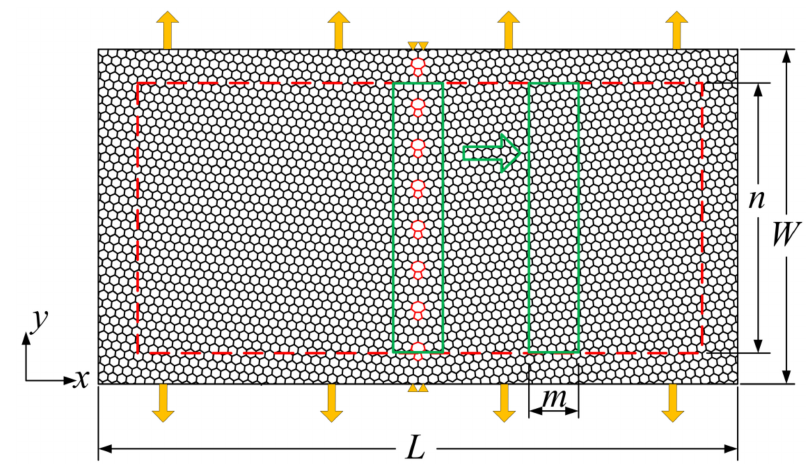
Figure 3. Schematic of the graphene model containing a zigzag-oriented